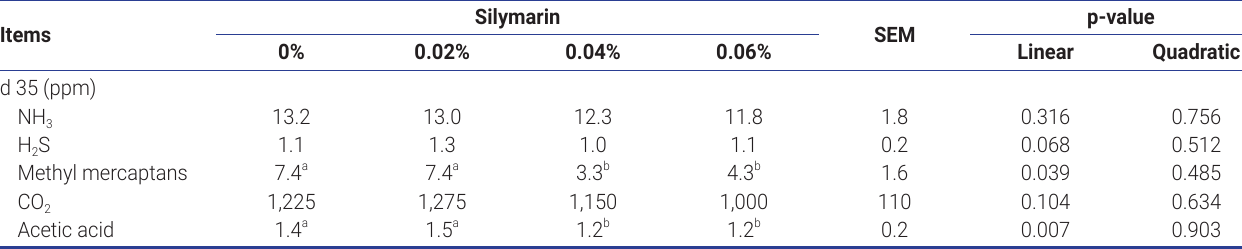
Table 5. The effect of Silymarin supplementation on the gas emission of broilers